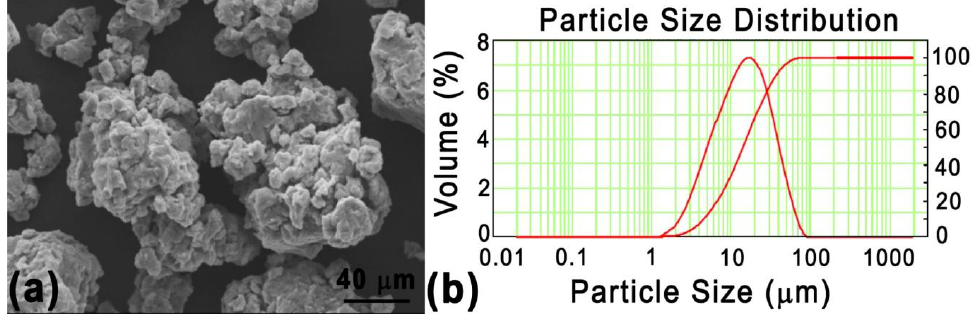
Figure. 2. ( a ) FE-SEM (field-emission scanning electron microscopy) image and ( b ) particle size distribution of Al 82 La 10 Fe 4 Ni 4 amorphous powder.